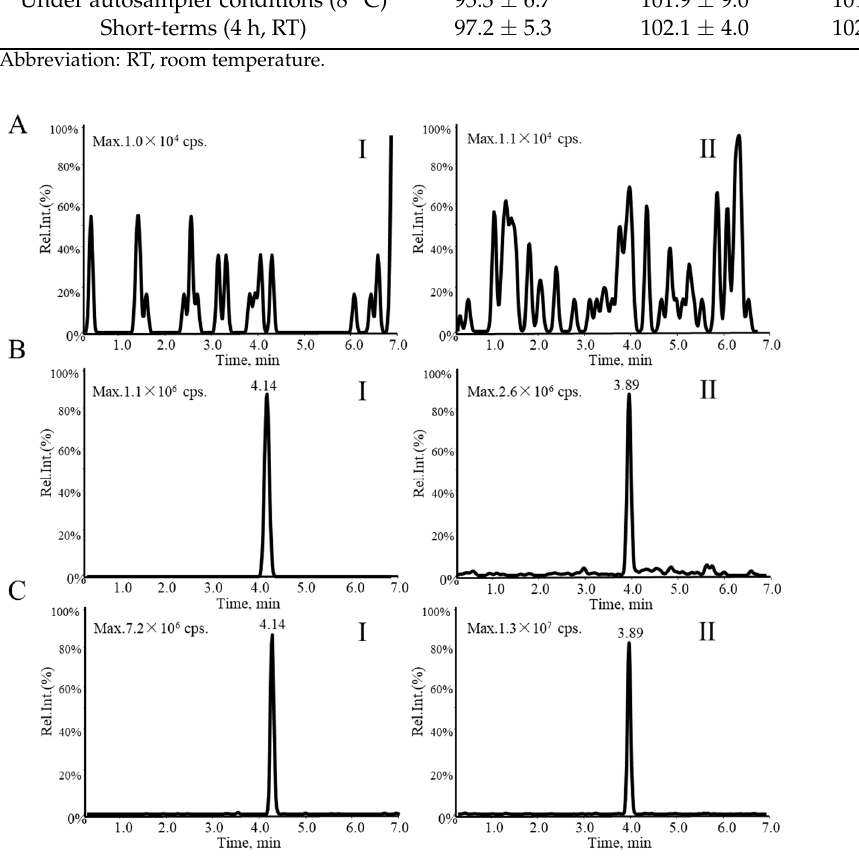
Table 3. Absolute matrix effects (%) and recoveries (%) for voriconazole (data are mean ± SD for n = 4).